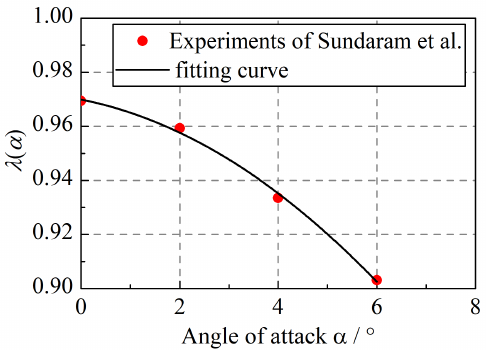
Figure 3. Drag reduction enhancement of angle of attack based on the data in